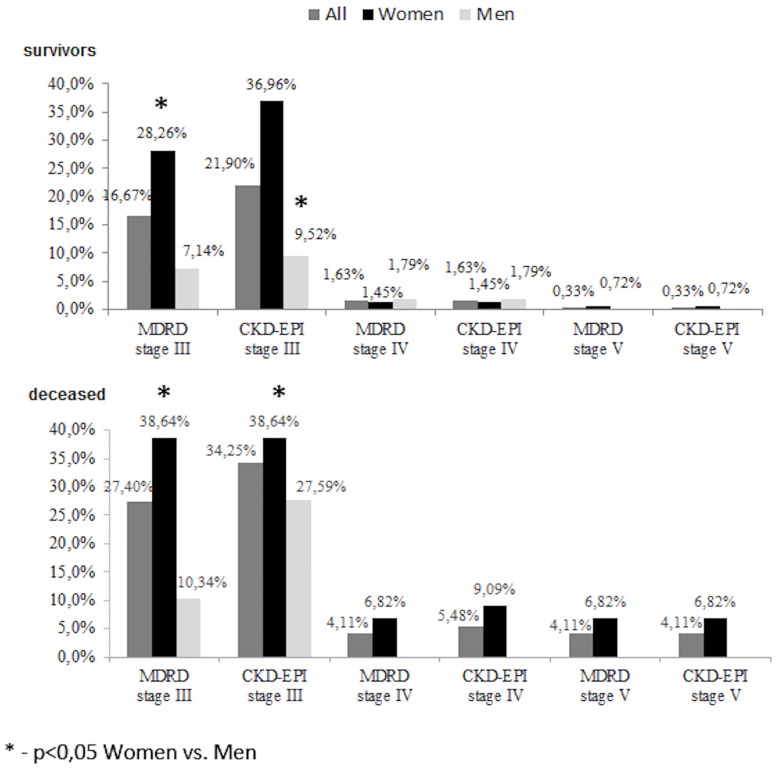
Distribution of stage 3 to 5 of chronic kidney disease on the basis of glomerular filtration rate measured according to MDRD and CKD-EPI formulas in post-IS subjects.